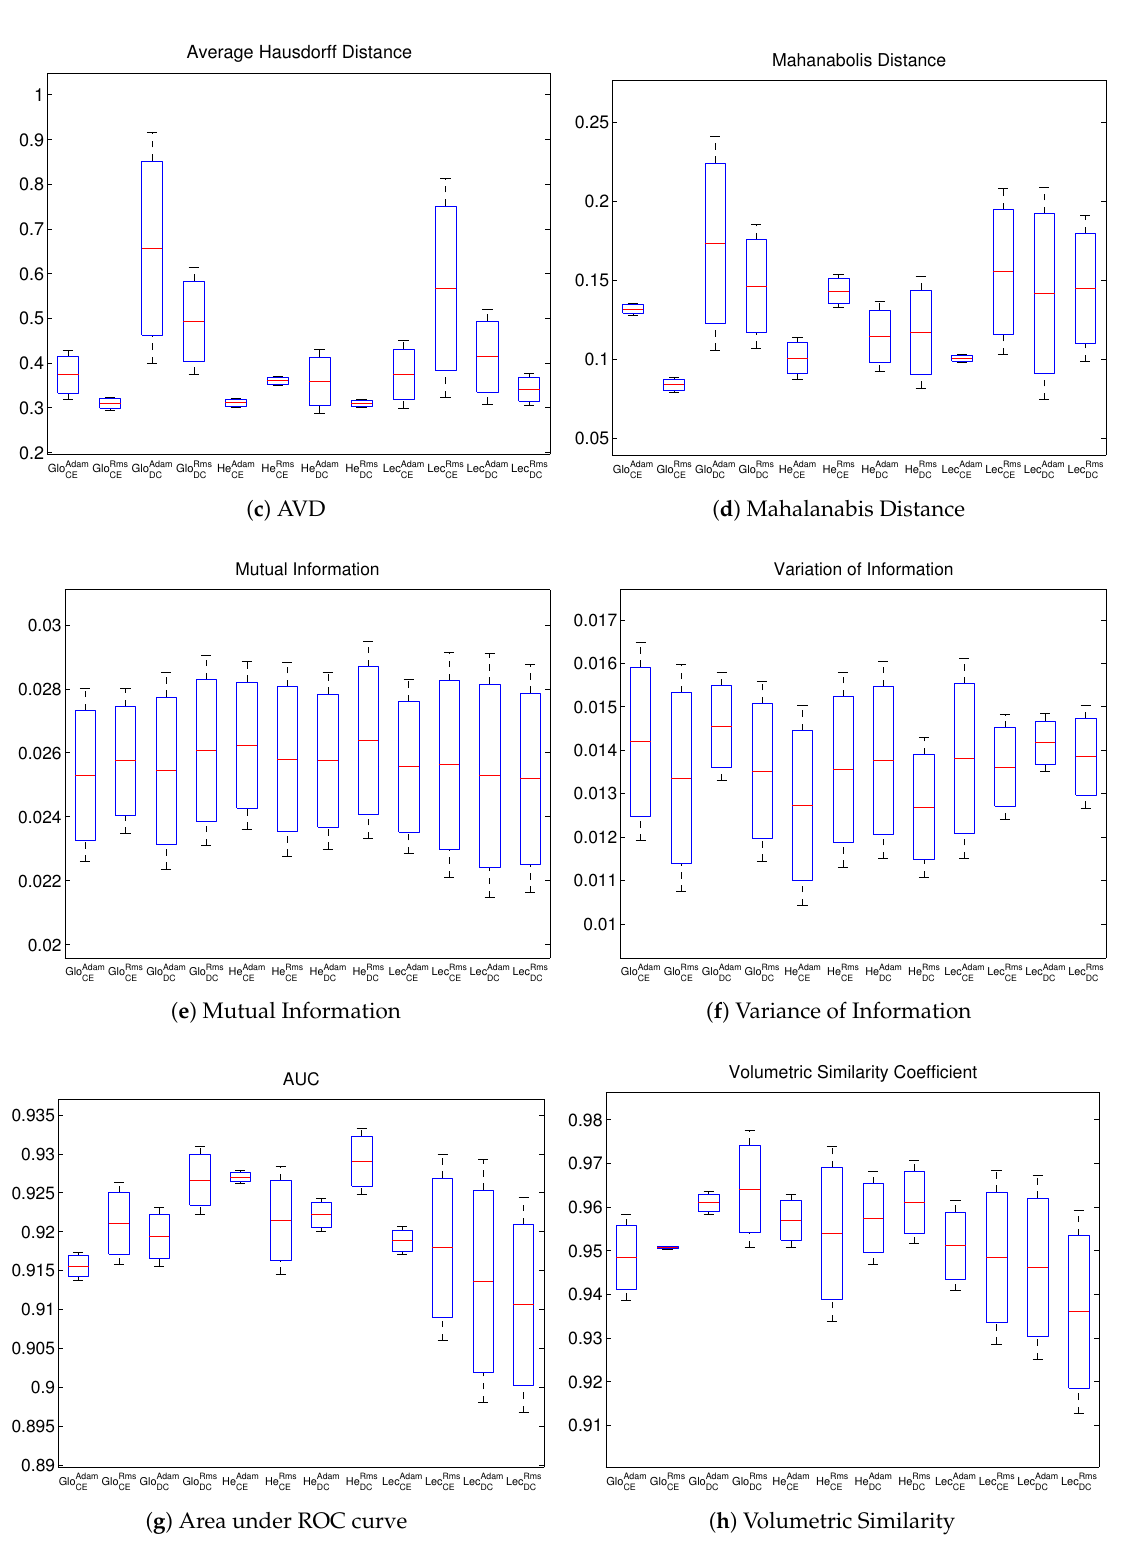
Figure 10. Box plots of metrics for Heart